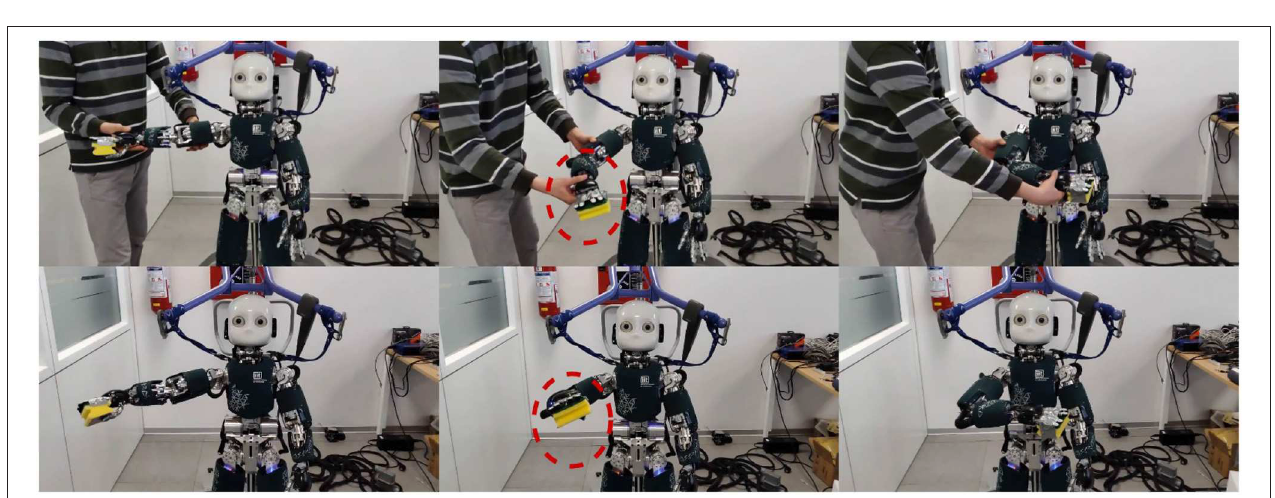
FIGURE 6 | Snapshots of human demonstrations (top row) in a transportation task and its corresponding reproduction (bottom row) under an